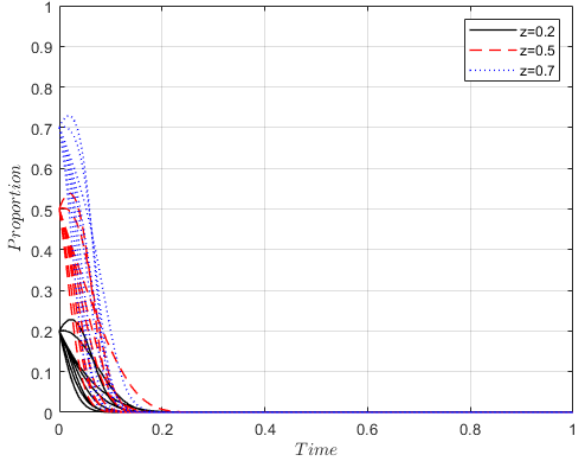
Figure 11. Evolutionary diagram when z differs.